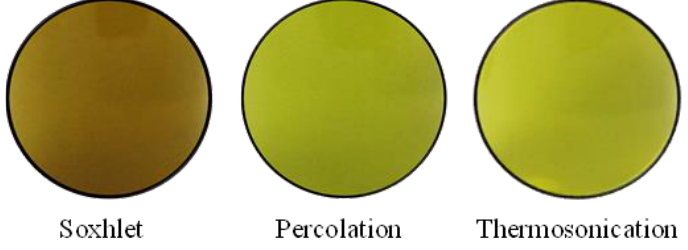
Figure 5. The effect of different extraction techniques on the visual appearance of fennel extracts. Despite this, the fennel extract obtained by Soxhlet presented the highest global yield. Table 2 presents extraction yields acquired for each extraction technique. Table 2. Global and extraction yields.